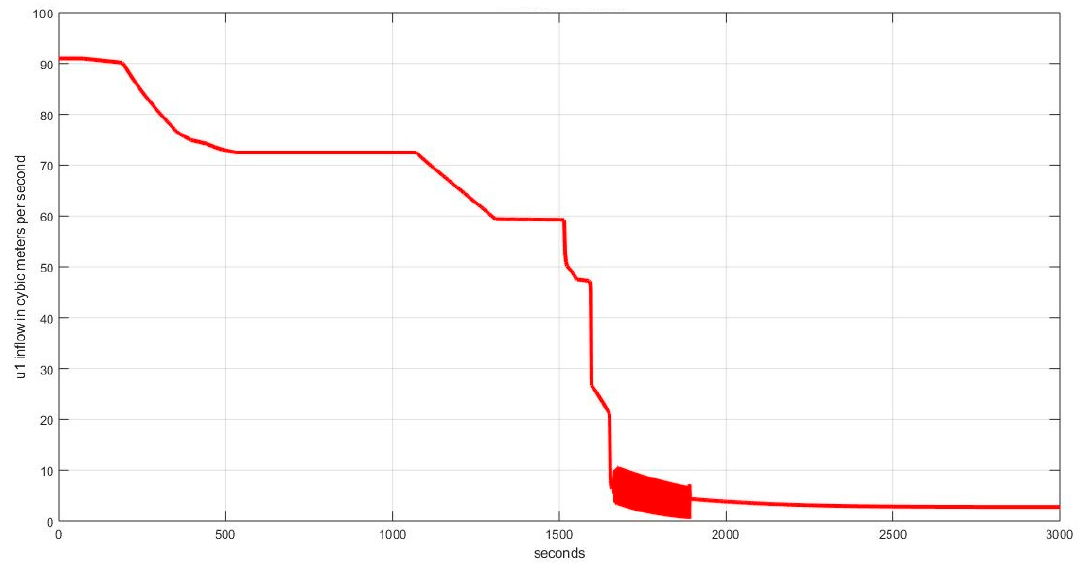
Figure 7. U1 control variable indicating the water inflow for the case in Figure 6.